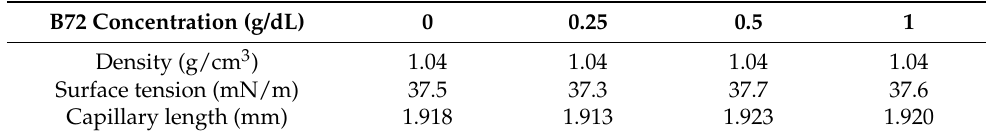
Table 1. Density of B72-benzyl alcohol solutions.